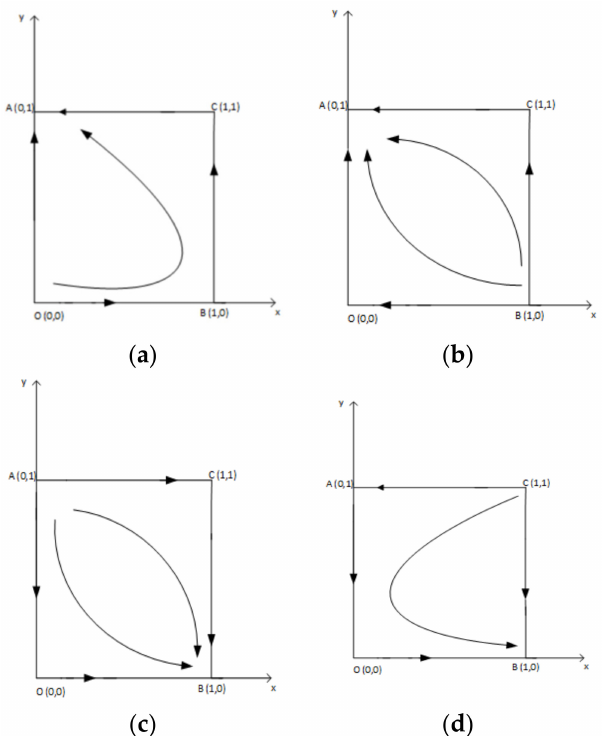
Figure 3. Evolutionary game phase diagrams for active online lending platforms. ( a ) Scenario I;